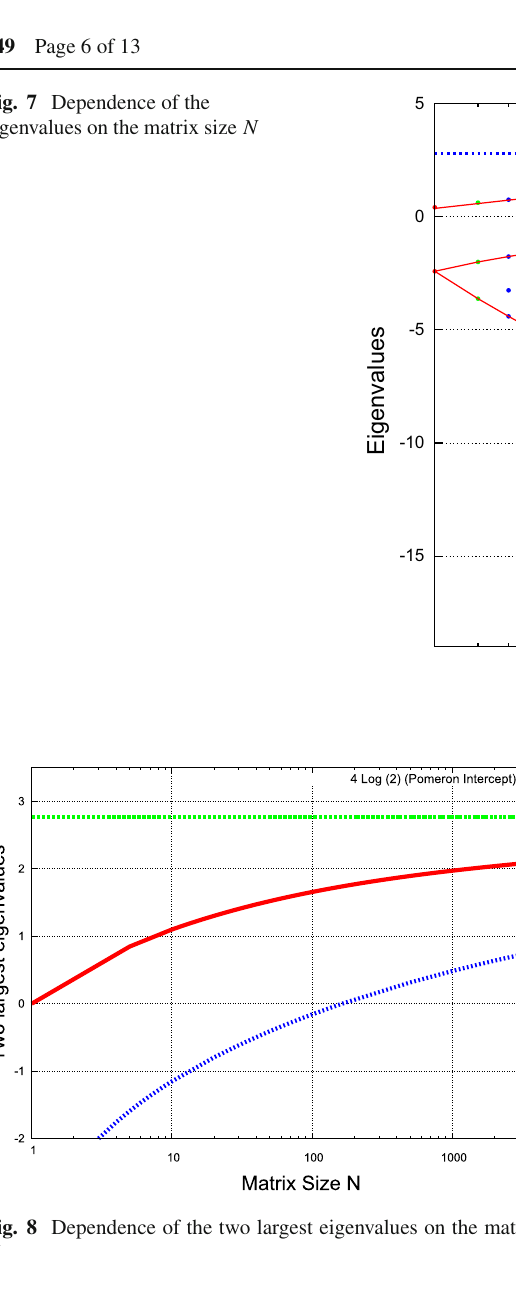
at this point that one should not expect that the square trun- cation of the BFKL matrix is the means of achieving a fast convergence towards the value 4 log(2). An example of a different approach with fast numerical convergence can be found in Ref. [30]. In the present context, Fig. 7 gives a proof of concept that it is consistent to study the eigenvalues of the square truncated BFKL matrix. If the asymptotic eigenstate ψ ( N ) as is investigated one will find that the distribution of its components (see Fig. 9) is similar to that found for BFKL in Fig. 4. In this analysis N = 100 has been used, N 0 = 20 and the coupling is α = 1, but the features here discussed are generic. From the asymptotic expression in Eq. (9) one can extract the following logarithmic